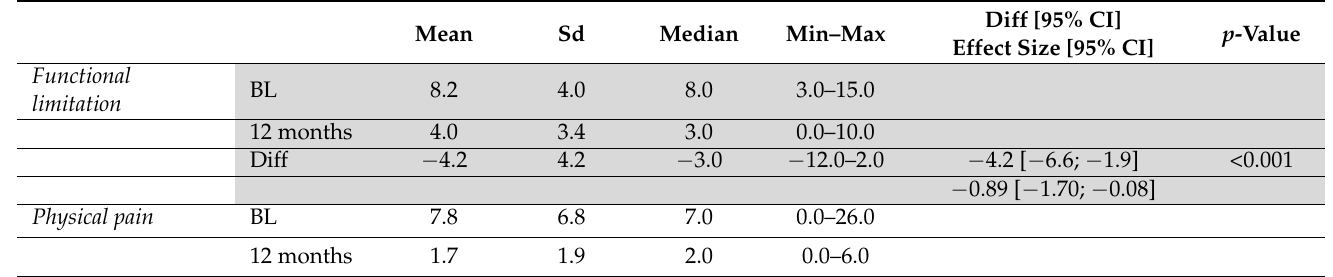
Table 1. Oral Health Impact Profile (OHIP) at baseline and after 12